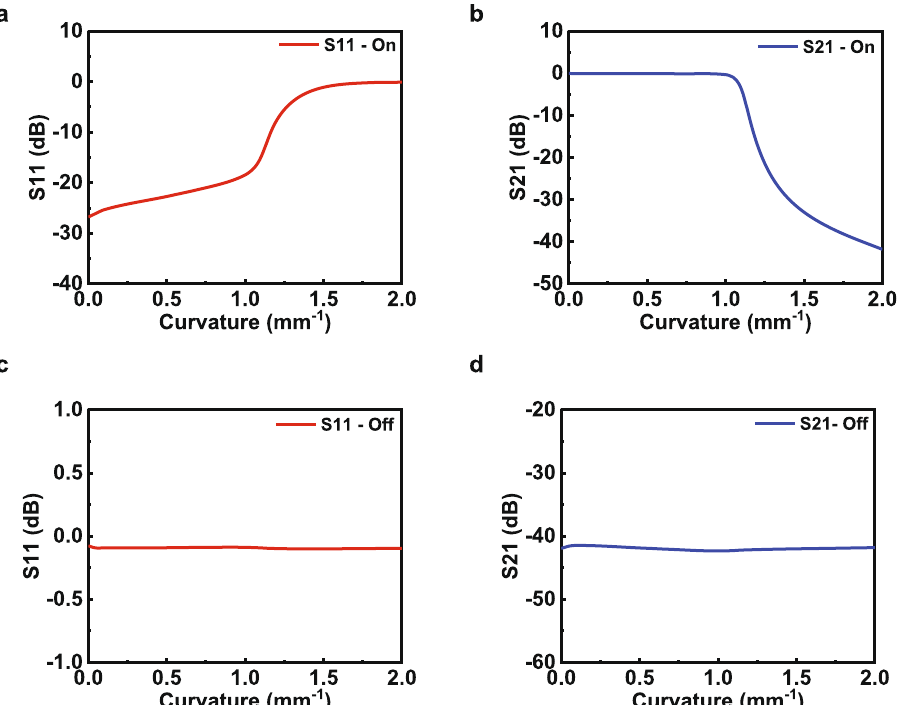
Fig. 7 Simulated RF characteristics of the RF MEMS switch with different bending curvatures. a On state S 11 . b On state S 21 . c Off state S 11 . d Off state S 21